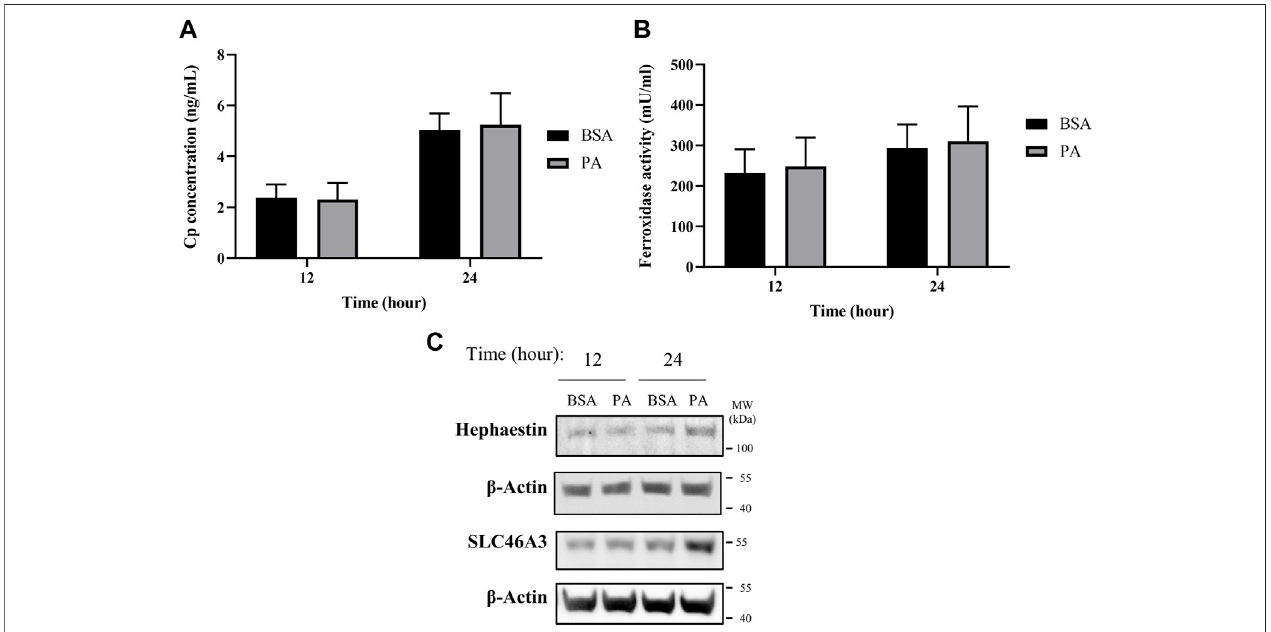
FIGURE 2 | PA does not alter secreted ceruloplasmin (Cp) but induces copper membrane localization and sequestration. (A) Cp concentration was measured by ELISA( n =4). (B) Copper-dependentferroxidaseactivityofCpinmediacollectedfromHepG2cellstreatedwithPAorBSAfor12and24 h( n =4).Mean±SEMisshown. The Mann – Whitney U test was used to assess signi fi cance (** p < 0.01). (C) Representative western blot images of hephaestin and